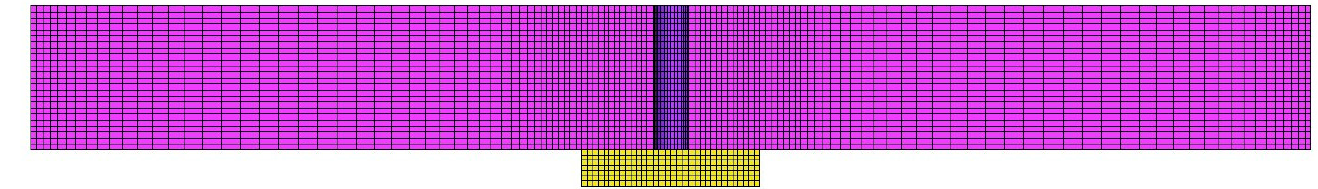
Figure 3. Seabed model (unit: mm).